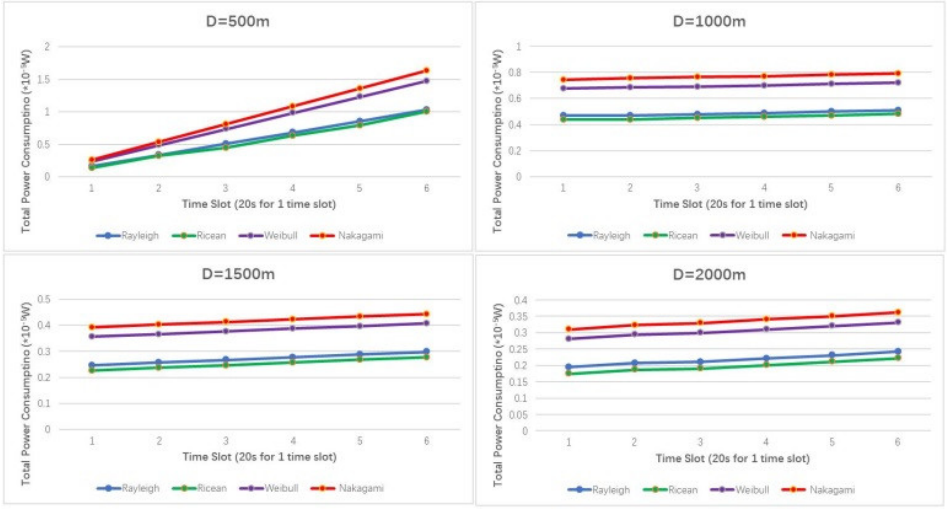
Figure 8. Total power consumptions by UAV L in different Ds under different fading channels.